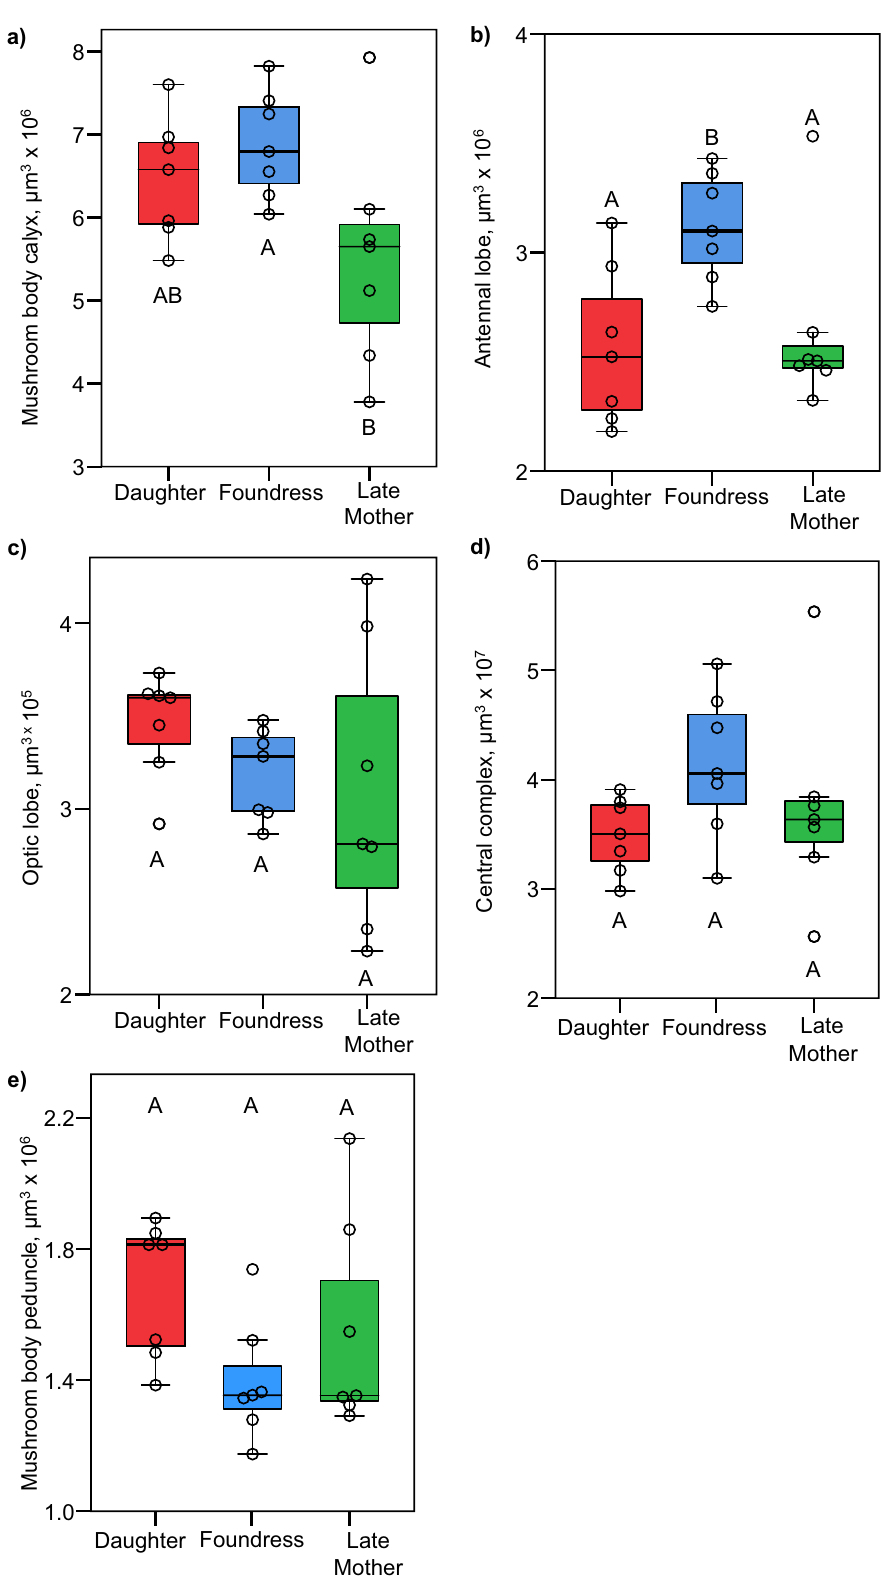
Figure 3. Size-corrected volumes of the mushroom body calyces ( a ), Antennal lobes ( b ), optic lobes ( c ), central complex ( d ), and MB peduncle ( f ) for each group (N = 7 for each group). Groups that do not share a letter are significantly different from each other based on an ANOVA followed by Tukey’s HSD pairwise